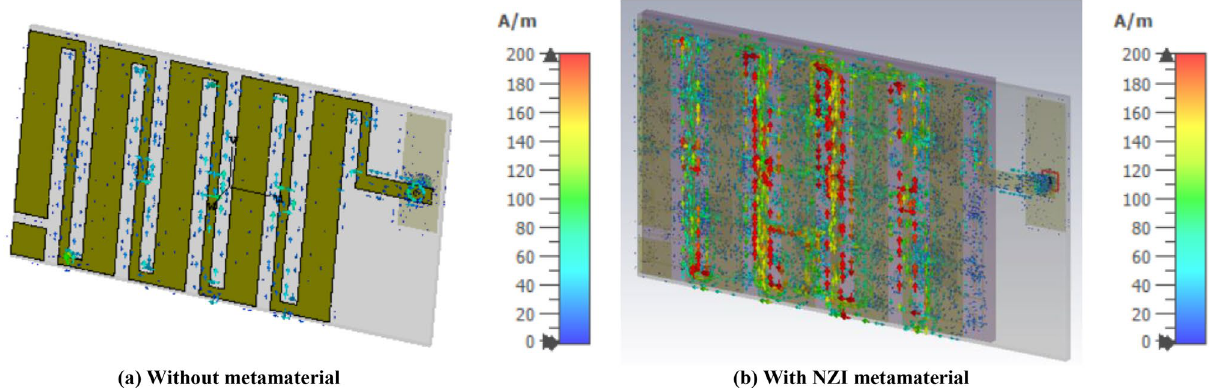
Figure 7. Surface current distribution of the proposed antenna (CST STUDIO SUITE 2019, https:// www. 3ds. com/ produ cts- servi ces/ simul ia/ produ cts/ cst- studio- suite) 16 .